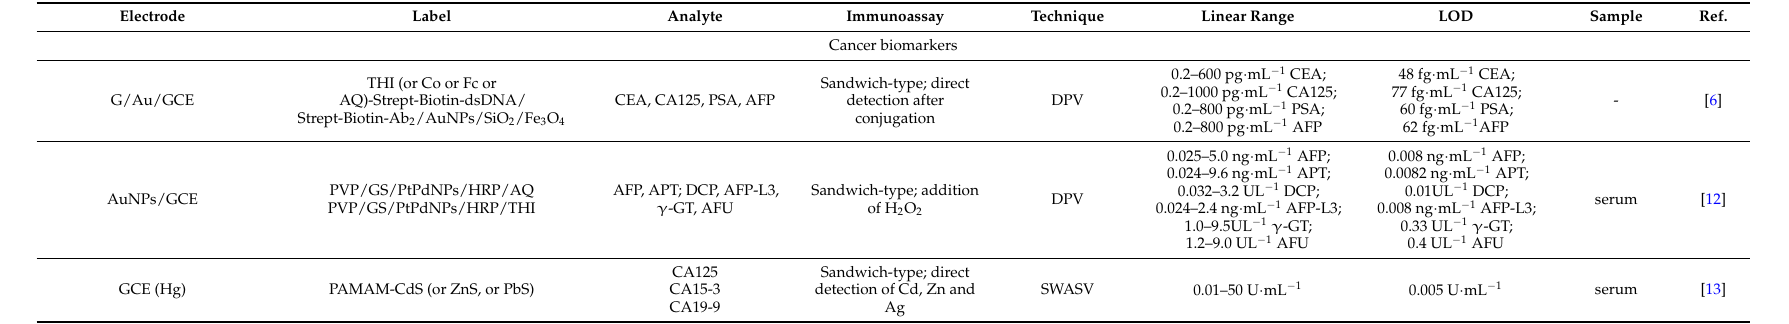
Table 2. Multiplexed electrochemical immunosensors using barcode